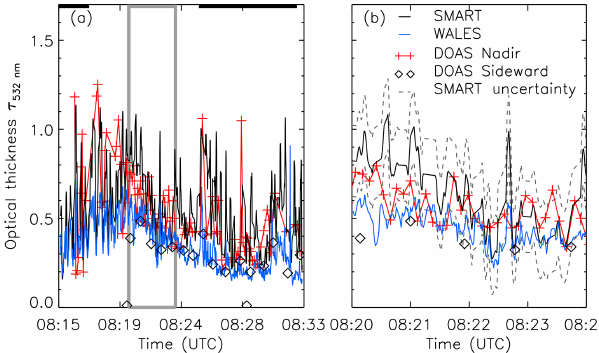
Figure 14. Time slices of the investigated flight segment on 26 March 2014 (a) and zoom (b) of τ at λ = 532nm retrieved from SMART (black line), WALES (gray line), mini-DOAS sideward viewing (diamonds) and nadir spectrometers (crosses) along the flight track of ML-CIRRUS flight on 26 March 2014. Periods with the second cloud layer are marked by the black lines at the top of (a)